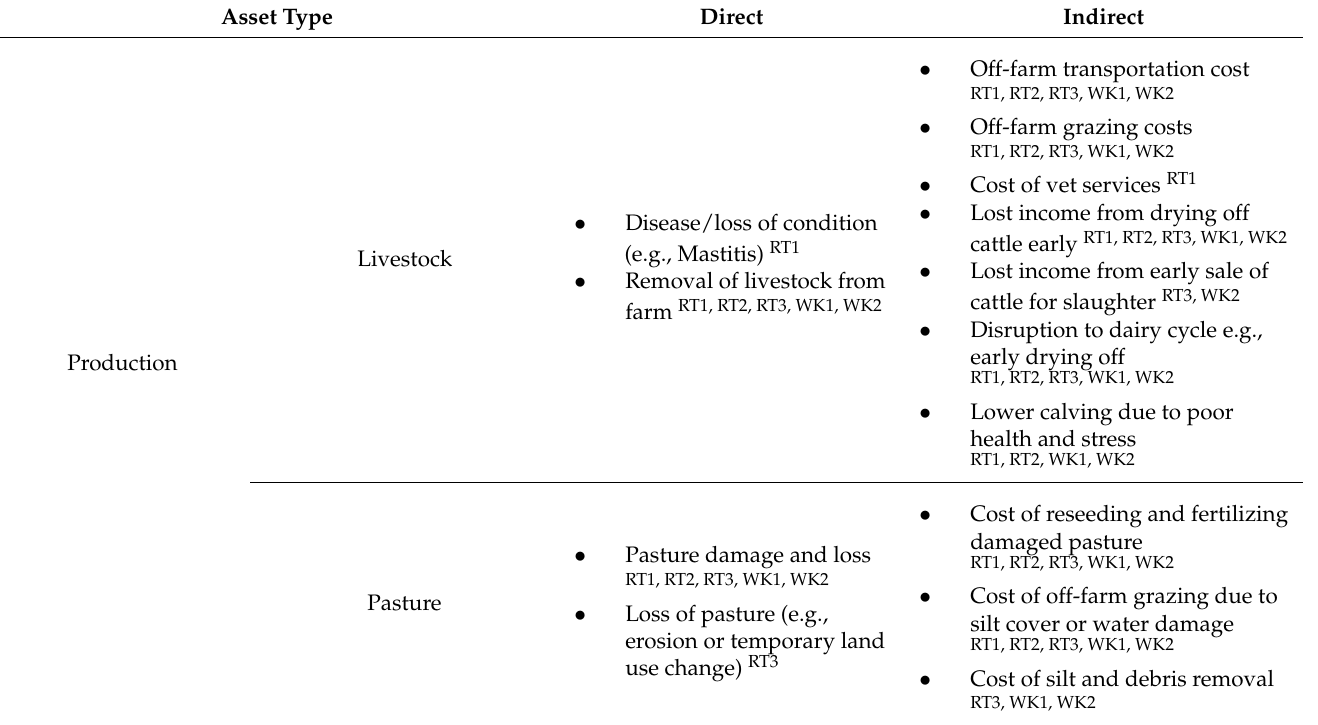
Table 3. A summary of direct and indirect damage type observed and reported on surveyed Bay of Plenty region dairy